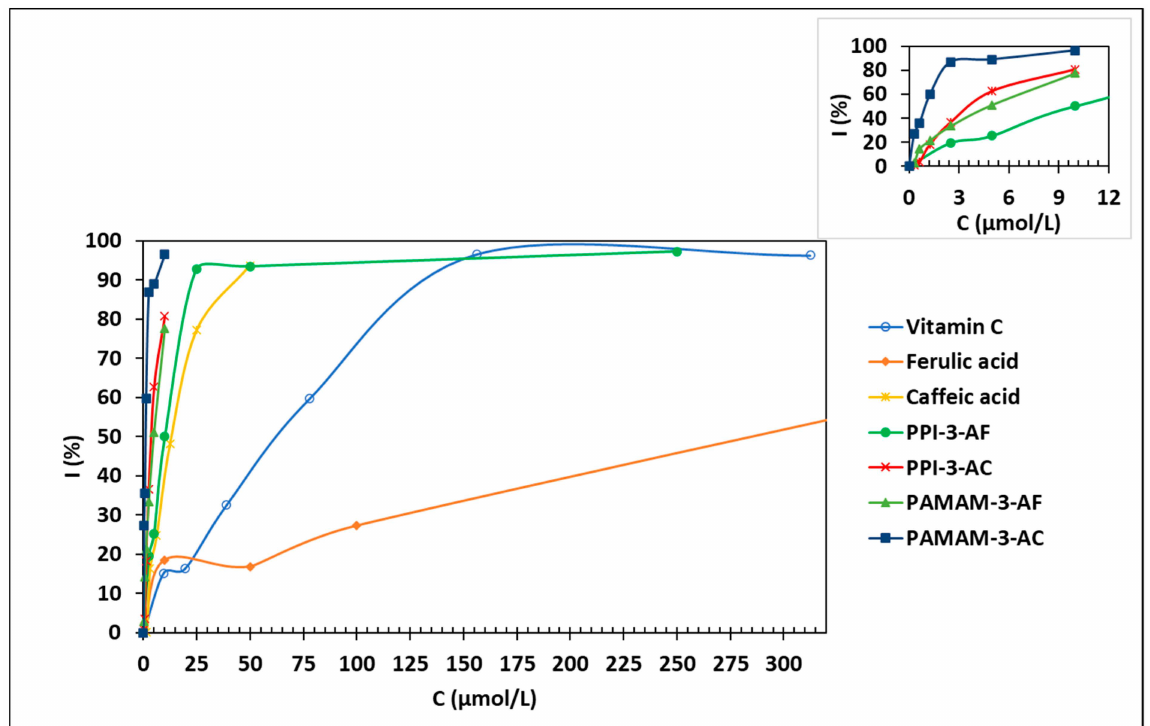
Figure 2. The inhibition of DPPH (300 µ M) by ionic antioxidant